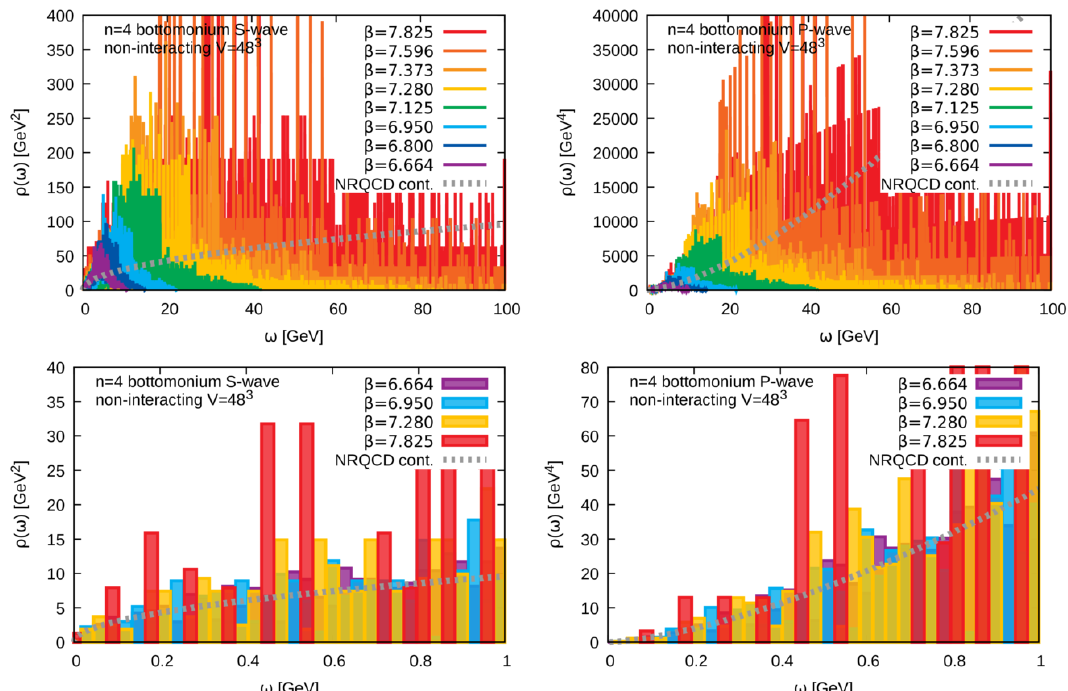
Figure 28 . A selection of lattice NRQCD bottomonium spectral function in the absence of inter- actions on 48 3 lattices at Lepage parameter n = 4. The S-wave channel is shown on the left, the P-wave channel on the right. The di(cid:11)erent colors correspond to a representative selection of the values of a s M b labeled by the corresponding (cid:12) values of the HotQCD ensembles. (top) The full frequency range populated by the free spectral functions is shown, note its extrusion up to very high frequencies for (cid:12)ne lattices. (bottom) Zoom-in of the low frequency regime. Here we wish to emphasize that the (cid:12)ner the lattice is, the fewer modes are available as constituents of possible spectral